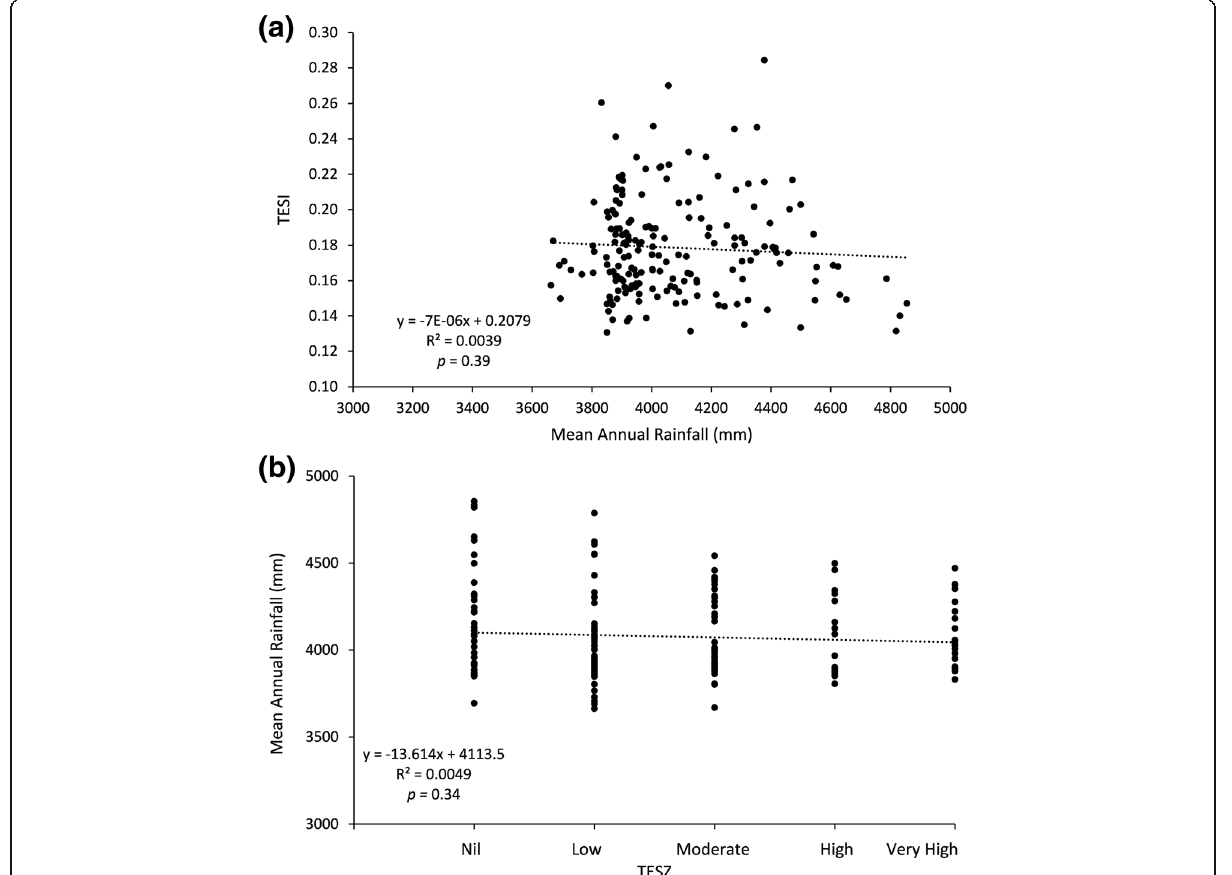
Fig. 8 Linear regression plots explaining the relationship between rainfall a TESI and b